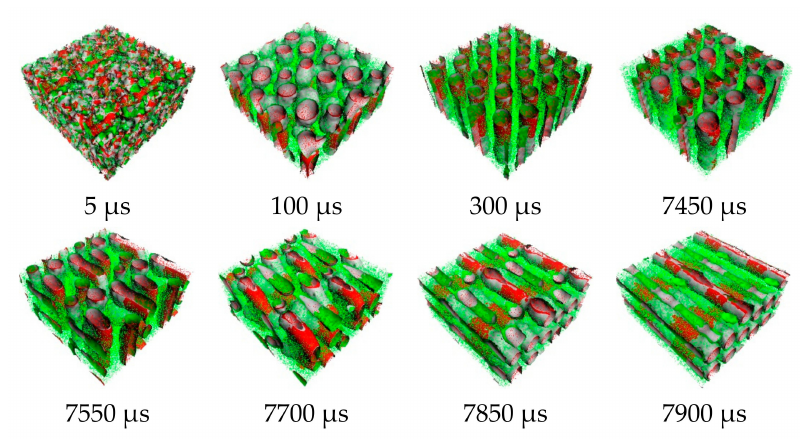
Figure 6. Snapshots of morphology evolution at annealing temperature of 493 K.